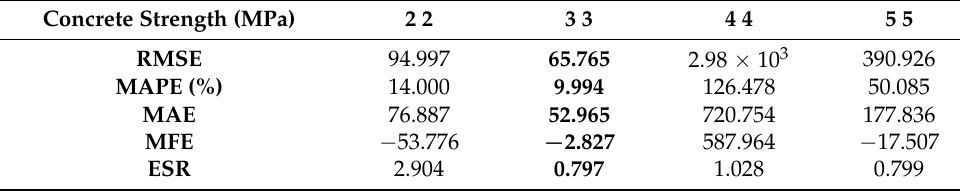
Table 7. Training results of the ANFIS model with triangular membership function ‘trimf’.